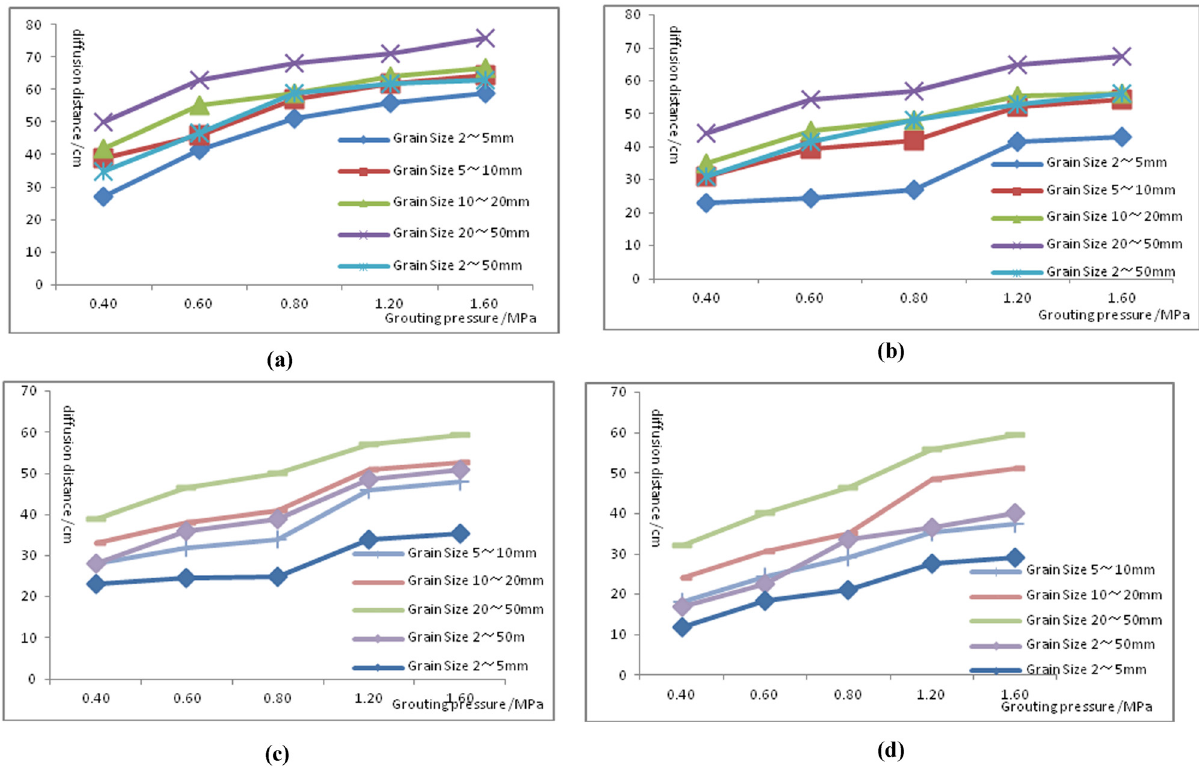
Figure 11: Graphs of the minimal diffusion distance of low - thermal asphalt in models with different gravel sizes in the 2D experiment: ( a ) strata pressure, 80 kPa; ( b ) strata pressure, 160 kPa; ( c ) strata pressure, 320 kPa; ( d ) strata pressure, 640 kPa.